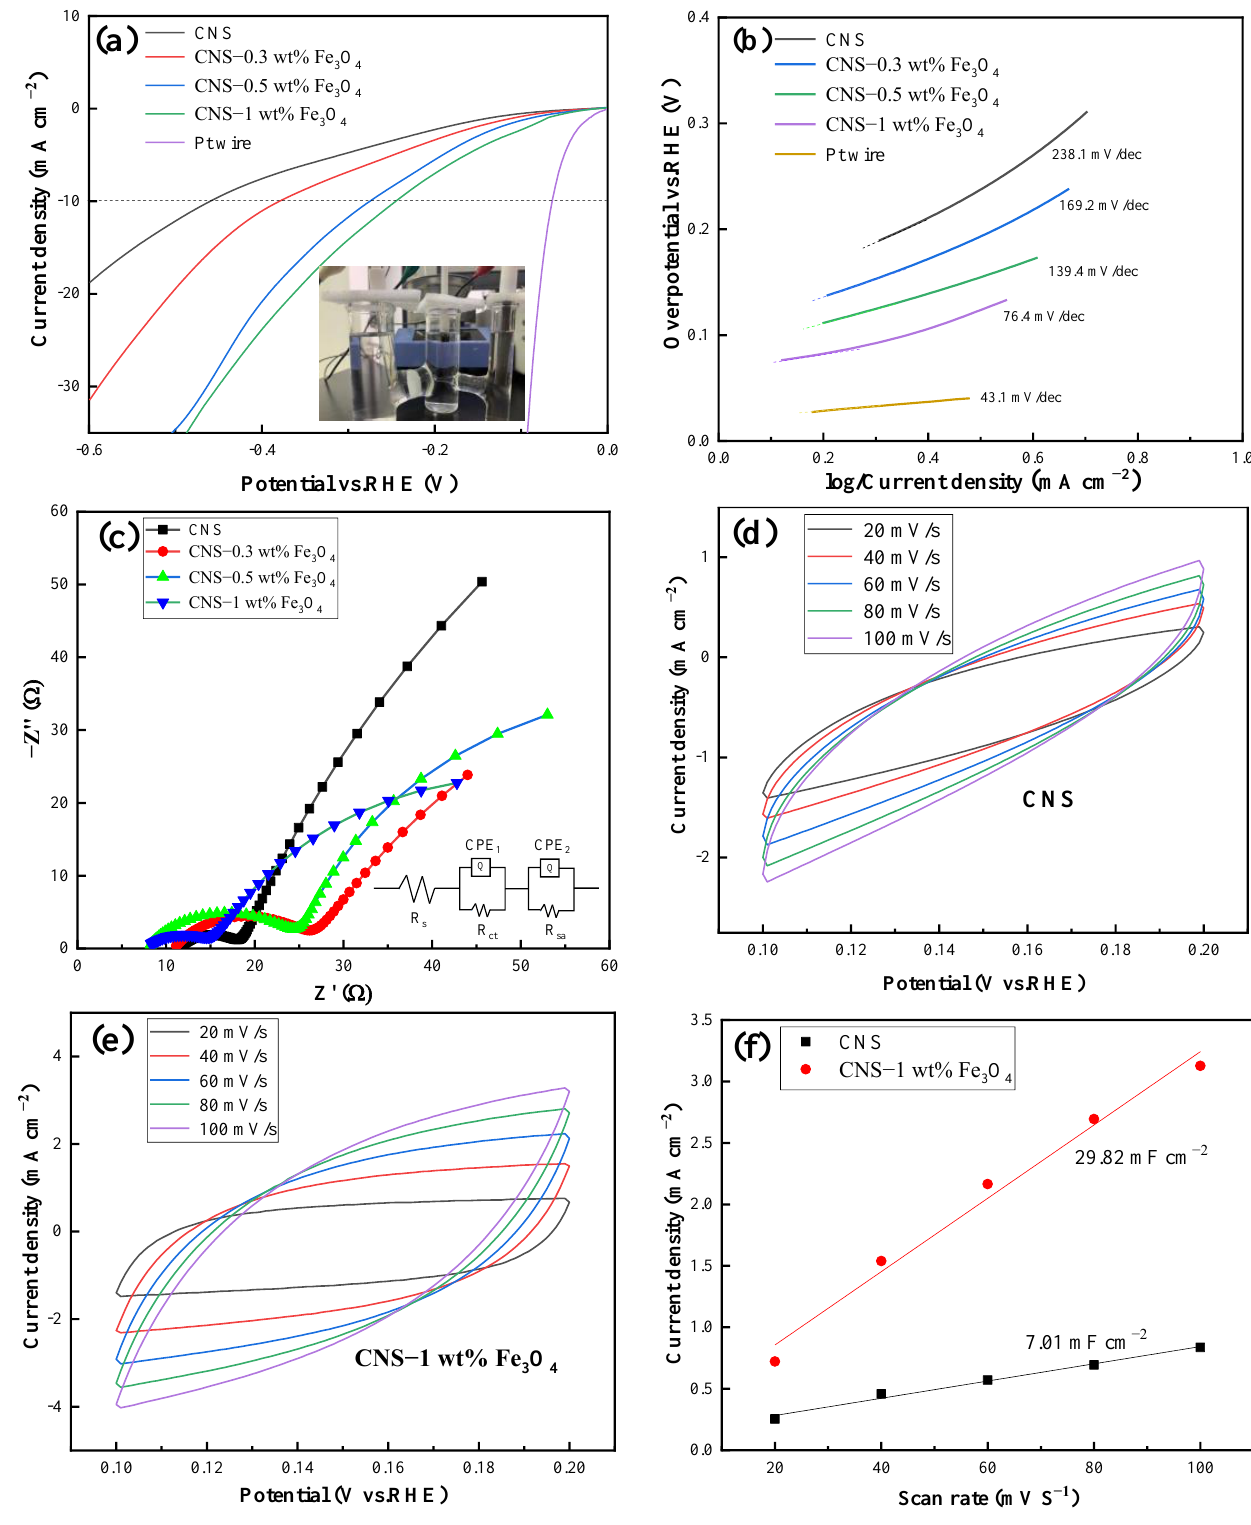
Figure 8. Electrochemical measurements in 1 M KOH. ( a ) LSV curves (inset is the photograph of the experimental setup), ( b ) Tafel curves, ( c ) Nyquist plots, ( d , e ) CV curve at different scan rates, ( f ) double-layer capacitances